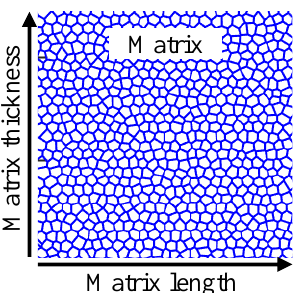
Fig. 1. Matrix shape and size, equivalent diameter 20 μm . Zoom in on a 500 μm x 500 μm square